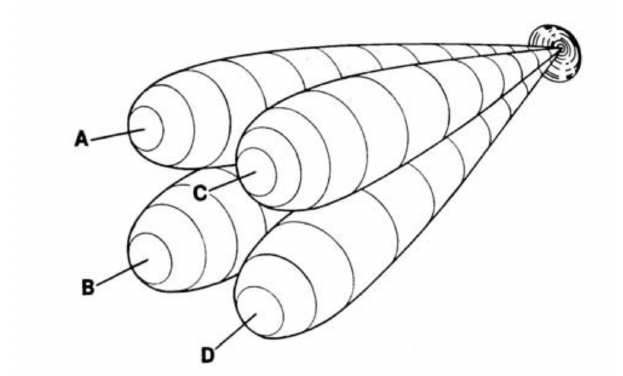
Figure 2. The lobe positions of the individual beams of a monopulse antenna